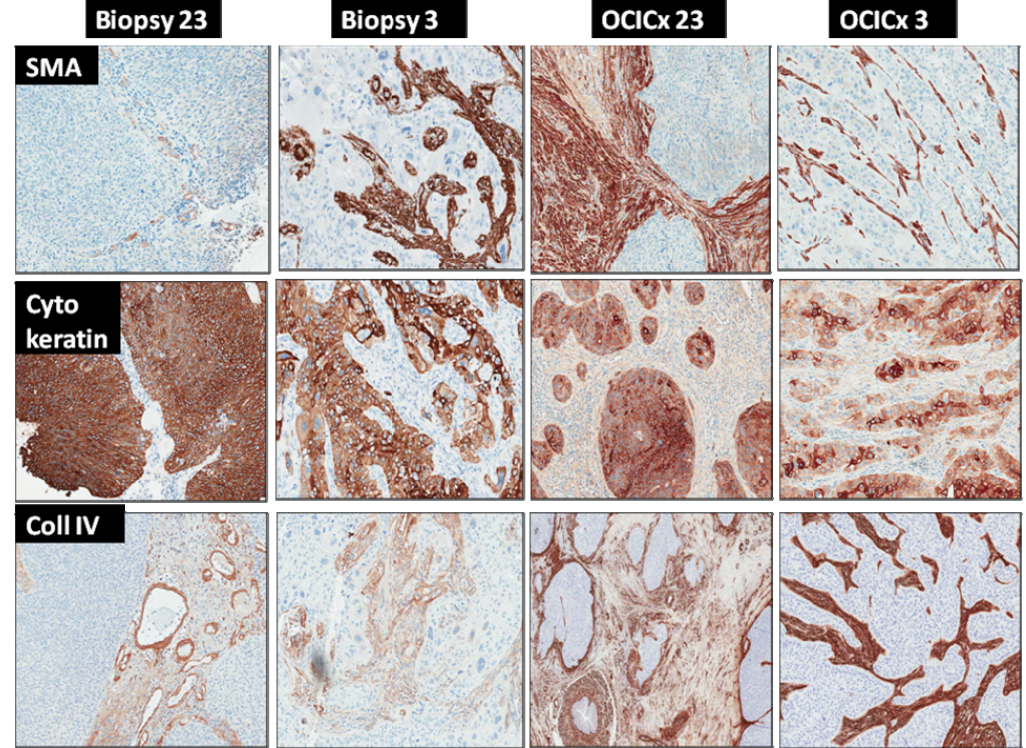
Supplementary Figure 2. Immunohistochemical staining of stromal and epithelial components in the biopsy and OCICx xenografts. IHC staining in the Biopsy 23 and Biopsy 3 respectively smooth muscle actin (SMA); collagen IV (coll IV); AE1AE3 cytokeratin in parallel sections. 15×